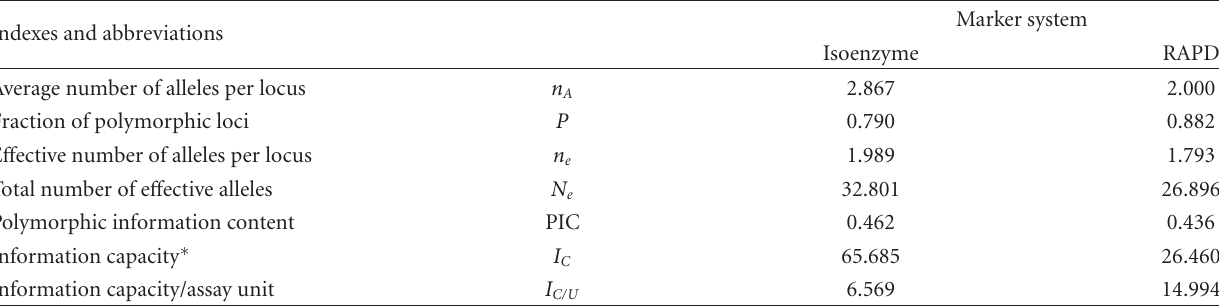
Table 6: Comparison of informativeness attained with codominant (isoenzyme) and dominant (RAPD)